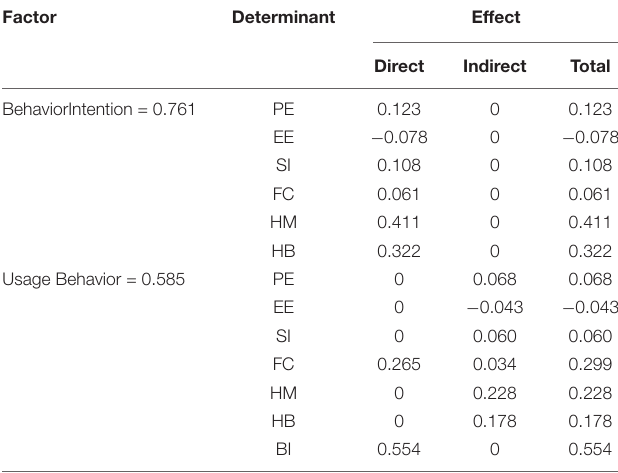
TABLE 8 | The direct, indirect, and total effects in the path model.